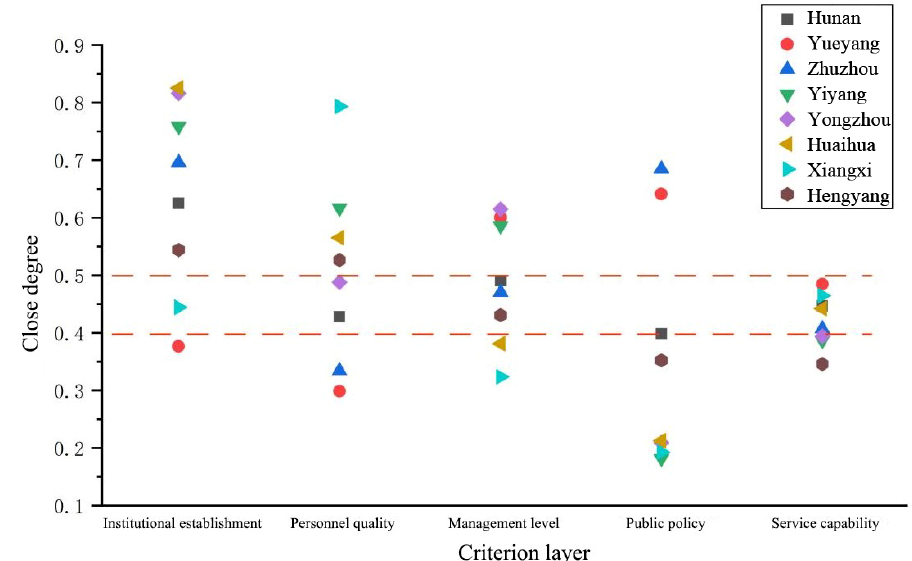
Figure 5. The second level of close degree of criterion layer of grassroots water service in Hunan Province.